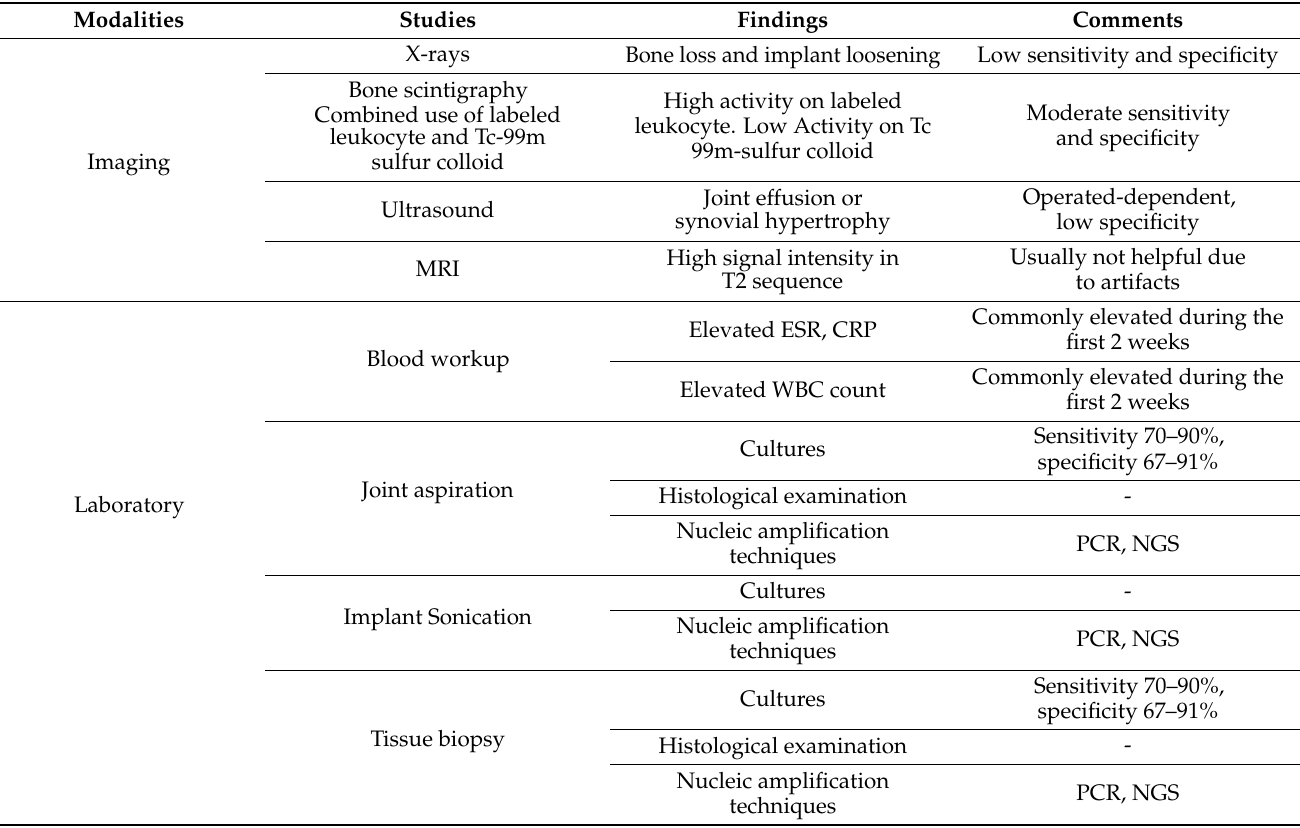
Table 2. Diagnostic modalities for infections of tumor